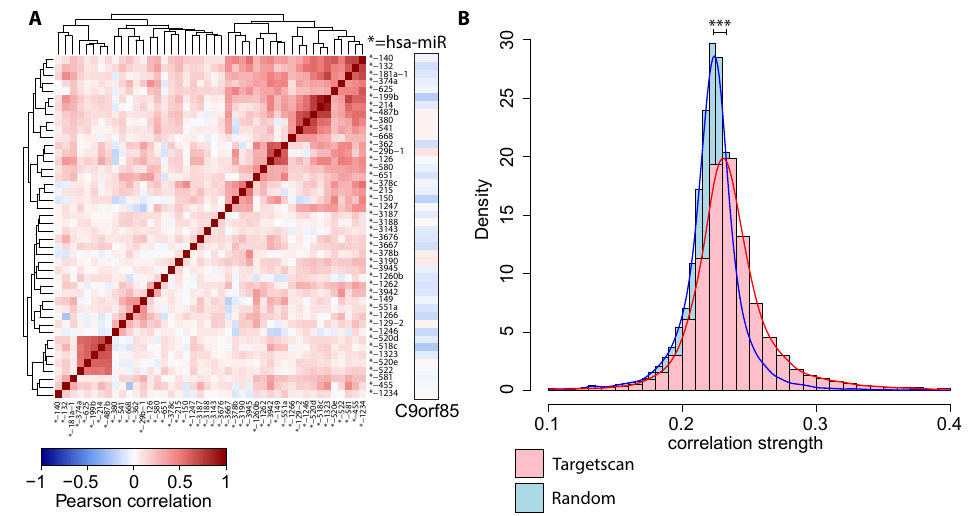
Figure 2. Collective effects of co-expressed miRNAs. ( A ) Pairwise correlation of putative, expressed miRNA regulators together with their target gene C9orf85 (obtained from the HNSCC dataset). The miRNAs are themselves clustered into several co-expressed groups; ( B ) The distribution of correlation strengths c ( X ) of miRNA sets, which are predicted to target a common gene, (red curve and histogram) is higher than for randomly re-sampled mi-/mRNA associations (blue, Wilcoxon rank sum test has p < 1 × 10 − 80 ) in the HNSCC miRNA expression